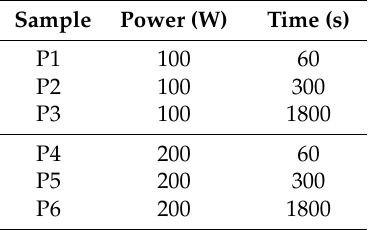
Table 1. Conditions used for the plasma treatment condition of PLA fibers.